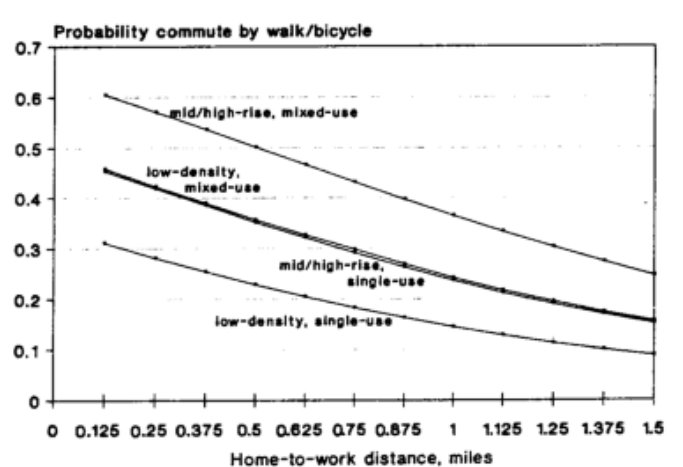
Figure 2. Probability of Commuting by Walking or Cycling, 11 U.S. Metropolitan Areas,